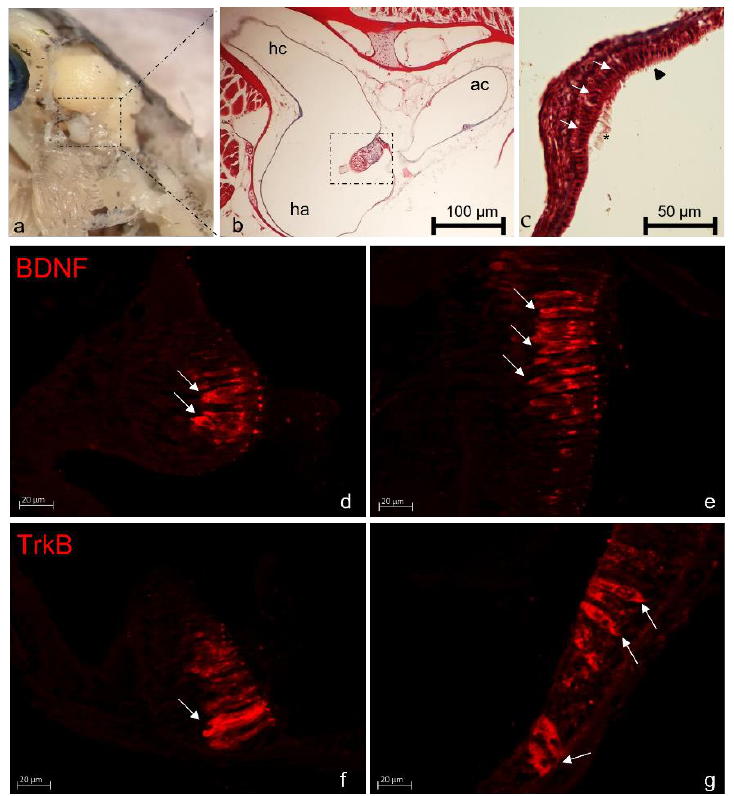
Figure 2. Stereomicrograph of zebrafish inner ear ( a ). Light micrograph of Masson Trichrome with aniline blue-stained dorso-ventral section of an adult zebrafish head; semicircular anterior canal (ac) and semicircular horizontal canal (hc) of the inner ear with its ampulla (ha) containing the crista ampullaris (dashed insert); ( b ). Utricular macula, sensory hair cells (white arrows) with numerous stereocilia (arrowheads) and less numerous but longer kinocilia (asterisk) are visible; ( c ). BDNF and TrkB immunoreactive sensory hair cells (arrows) in the crista ampullaris ( d , f ) and in the macula ( e , g ). Magnification 20× ( b ); 40× ( c – g ).